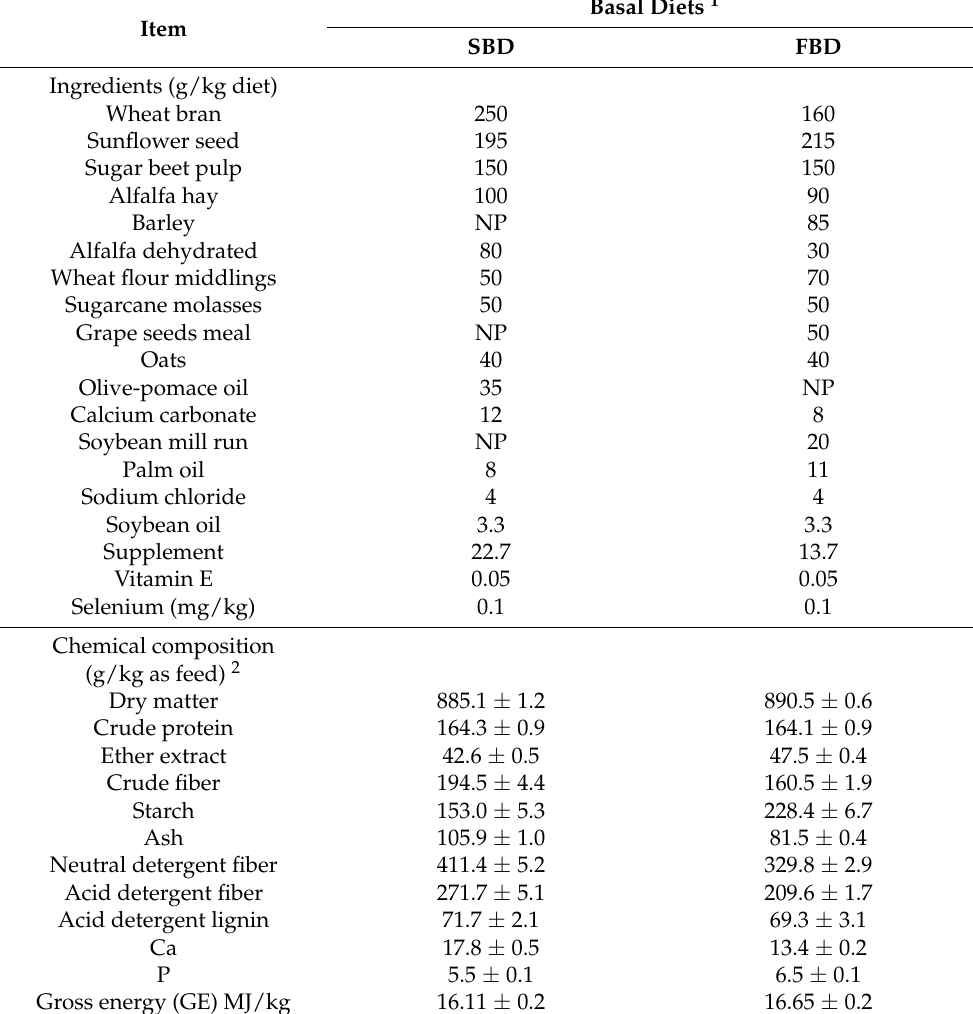
Table 1. Ingredients and chemical composition of the starter and finisher rabbit basal diets (Data from Minardi et al. [5]).